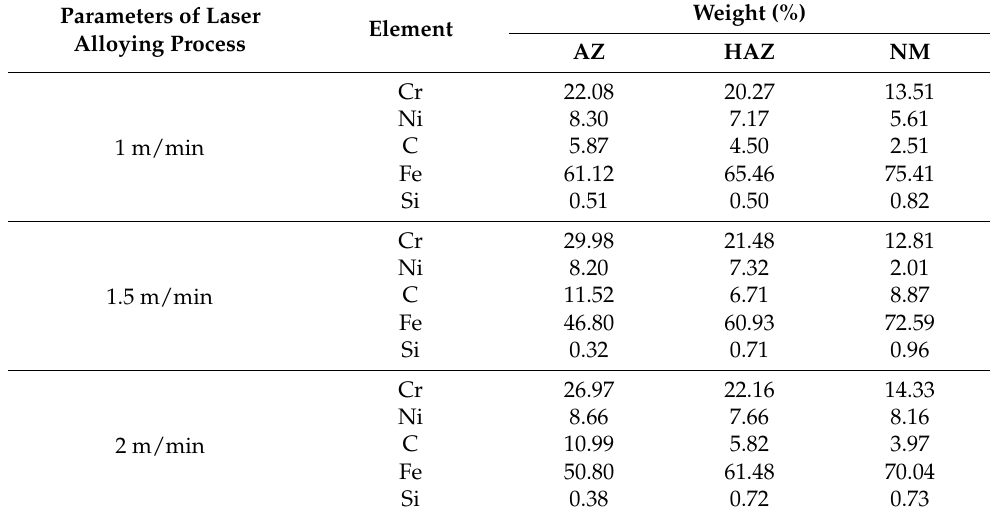
Table 6. EDX–analysis after laser alloying (AZ—alloying zone, HAZ—heat-affected zone, NM— native material) for sample 2.